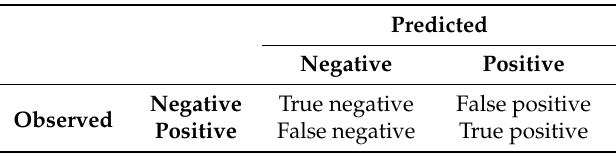
Table 2. Confusion